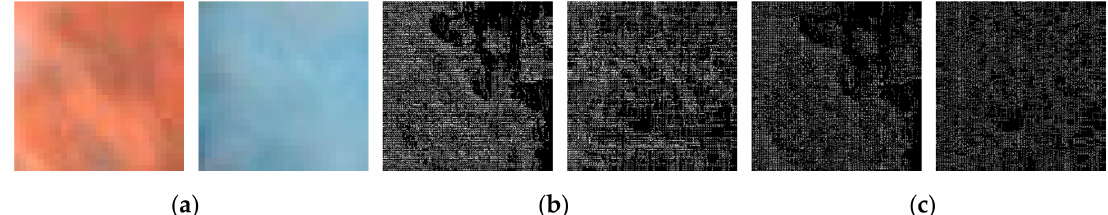
Figure 6. Visualization of: ( a ) candidate fire and smoke blocks, ( b ) transition matrices A and ( c ) mapping matrices